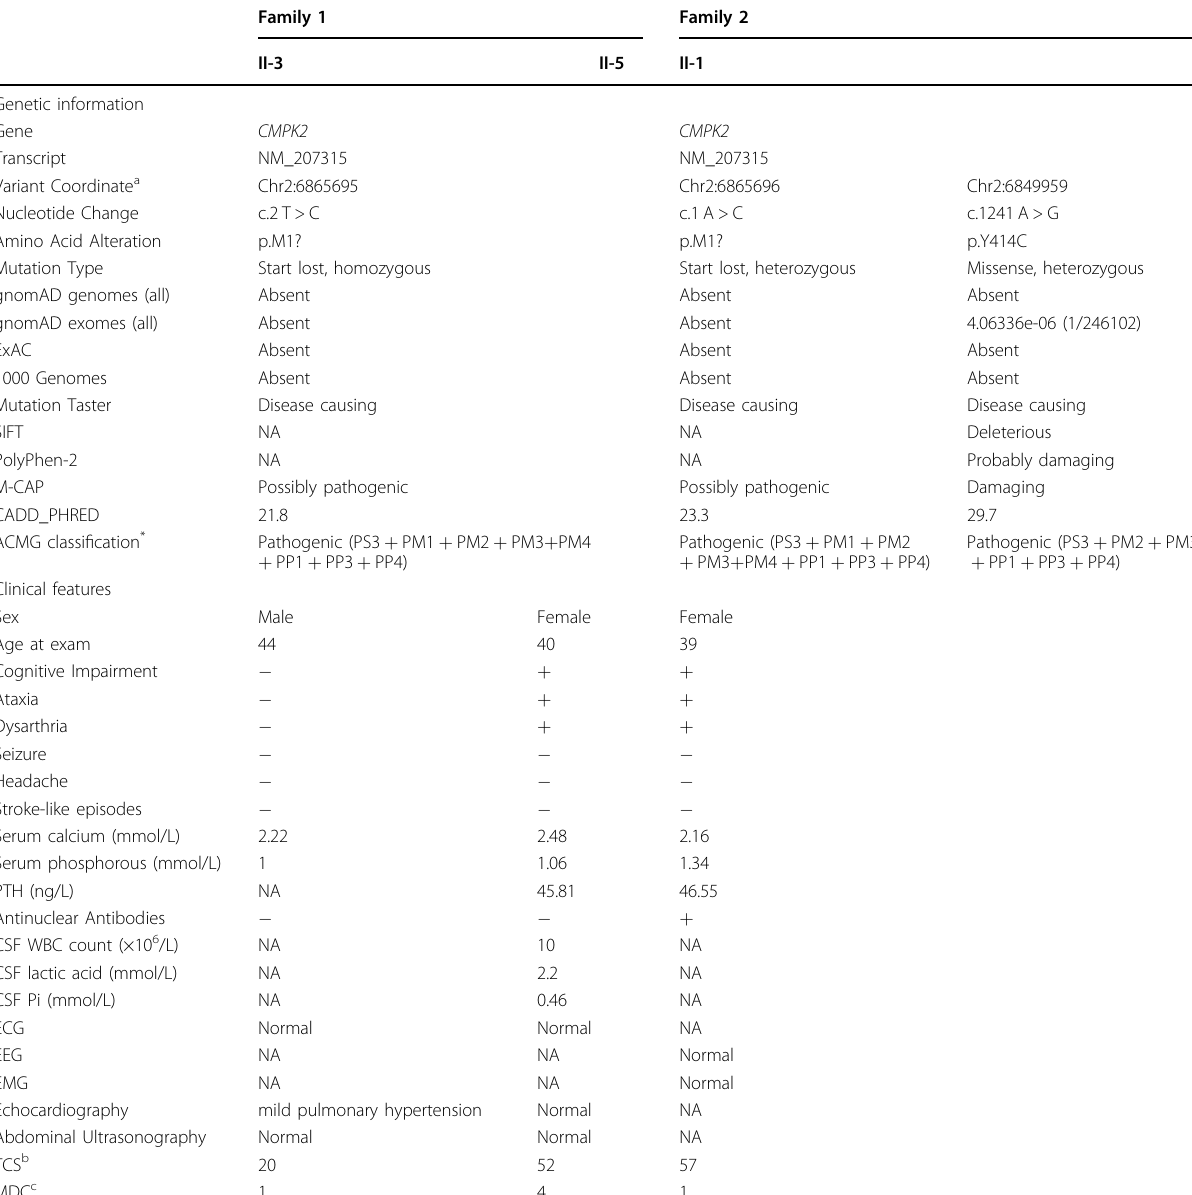
Table 1 A summary of genetic and clinical features in patients with CMPK2